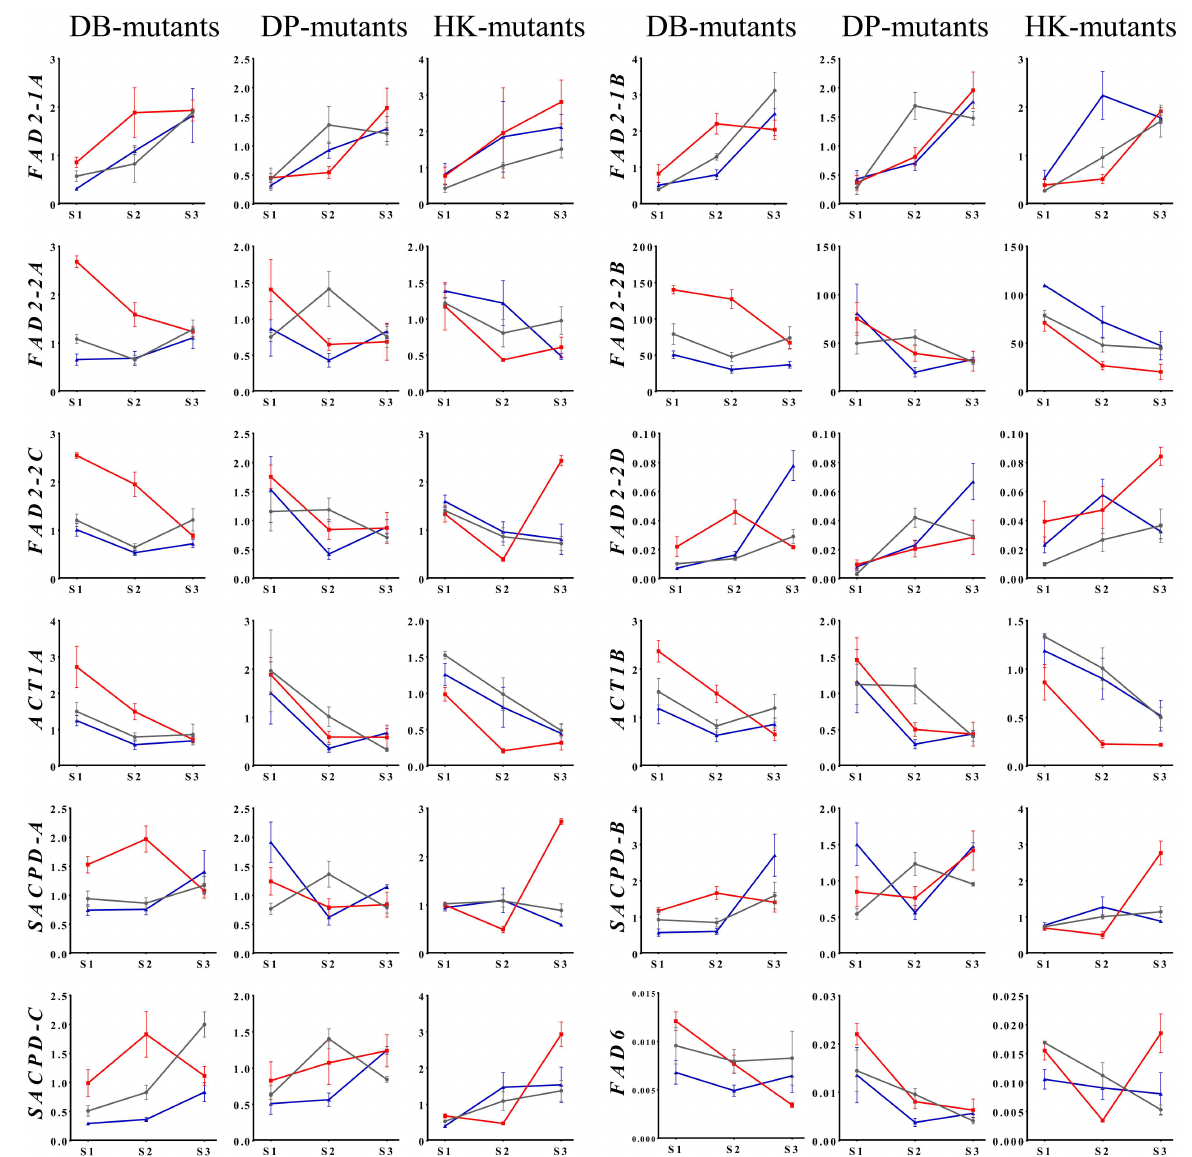
Figure 3. Relative expression level of fatty acid biosynthesis genes in seeds of soybean ‘Danbaek-mutants’ (Black line, DB; red line, DB-075; blue line, DB-041), ‘Daepung-mutants’ (Black line, DP; red line, DP-056; blue line, DB-184), and ‘Hwangkeum-mutants’ (Black line, HK; red line, HK-30; blue line, HK-37) MDP lines at three developmental stages. Expression levels were estimated using quantitative real-time PCR analysis. The relative expression level was normalized to the internal reference gene ELF1B